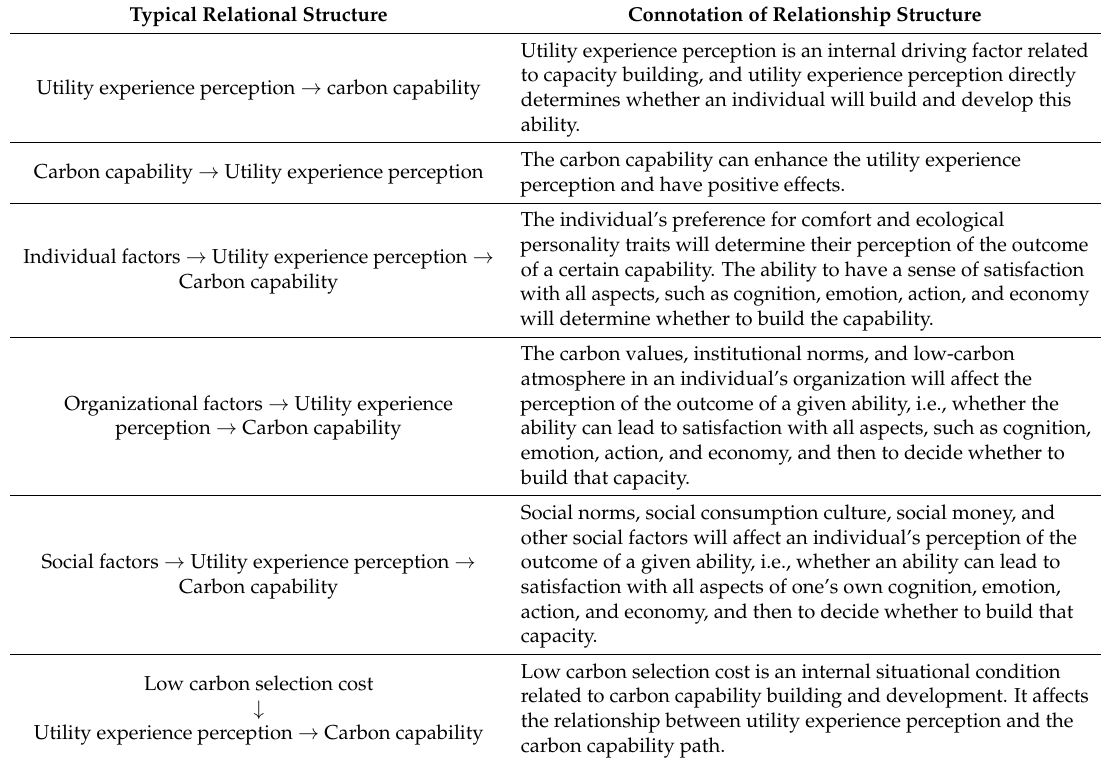
Table 5. Selective coding